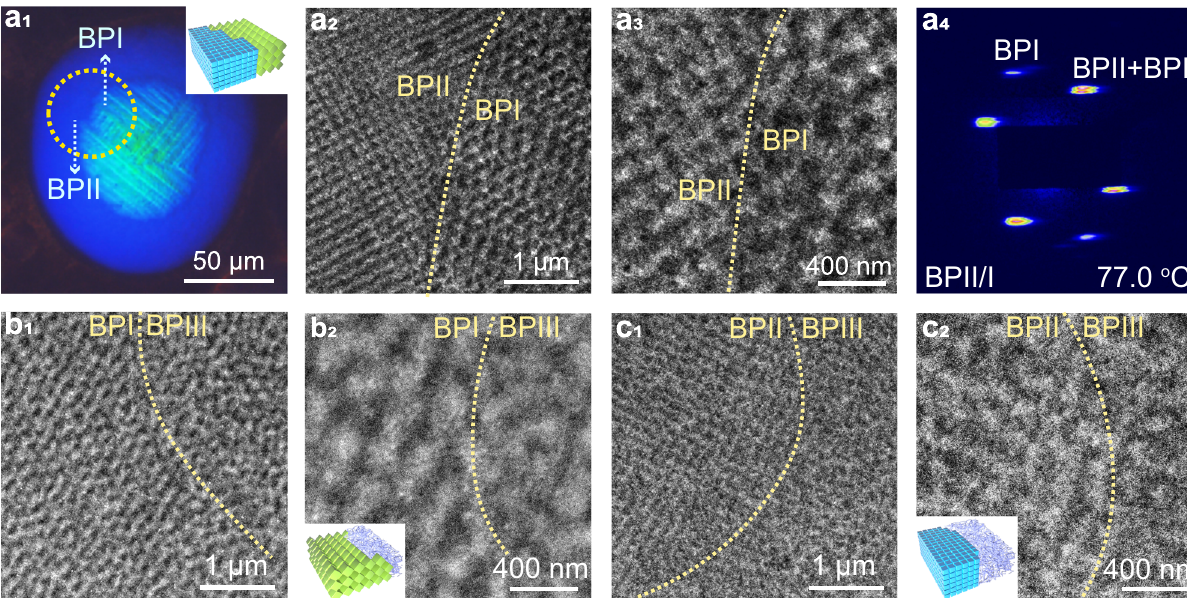
Fig. 3 TEM images and syn-SAXS analysis of the core-shell con fi gurations of BPI/BPII/BPIII, BPI/BPIII, and BPII/BPIII. a 1 Textures observed in re fl ection mode using cross-polarized microscopy. The yellow circle highlights the monophase or interface in core-shell con fi gurations. The inserts in a 1 , b 2 , and c 2 are schematic illustrations of the arrangements of cubic cells at the interfaces of BPIII, BPII, and BPI or monophasic BPII and BPI. a 2 , a 3 TEM images of the interface between BPI {110} and BPII {100} , b 1 , b 2 the interface between BPI {110} and BPIII, and c 1 , c 2 the interface between BPII {100} and BPIII. a 4 Syn- SAXS patterns with background subtracted from a monodomain a 4 hybrid phase of BPI {110} and BPII {100} . “ BPII/I ” refers to hybrid phases of BPII and BPI. The crystal lattices of BPI and BPII are coherent and a DTC can simultaneously exist in both BPI and BPII units, con fi rming that the DTC undergoes a recon fi guration process without diffusion. In addition, a DTC is observed across the interface of BPIII/BPI or BPIII/BPII, indicating that the DTCs do not diffuse when phase transition occurs from BPIII to BPII or BPI. The interfaces of BPI/BPII, BPII/BPIII, and BPI/BPIII are clear without a nearby transitional region. Based on the syn-SAXS results in reciprocal-space, the crystal orientation relationship between BPI and BPII is con fi rmed as {211} BPI //{110} BPII . Moreover, a perfect monodomain BPI with a large size is